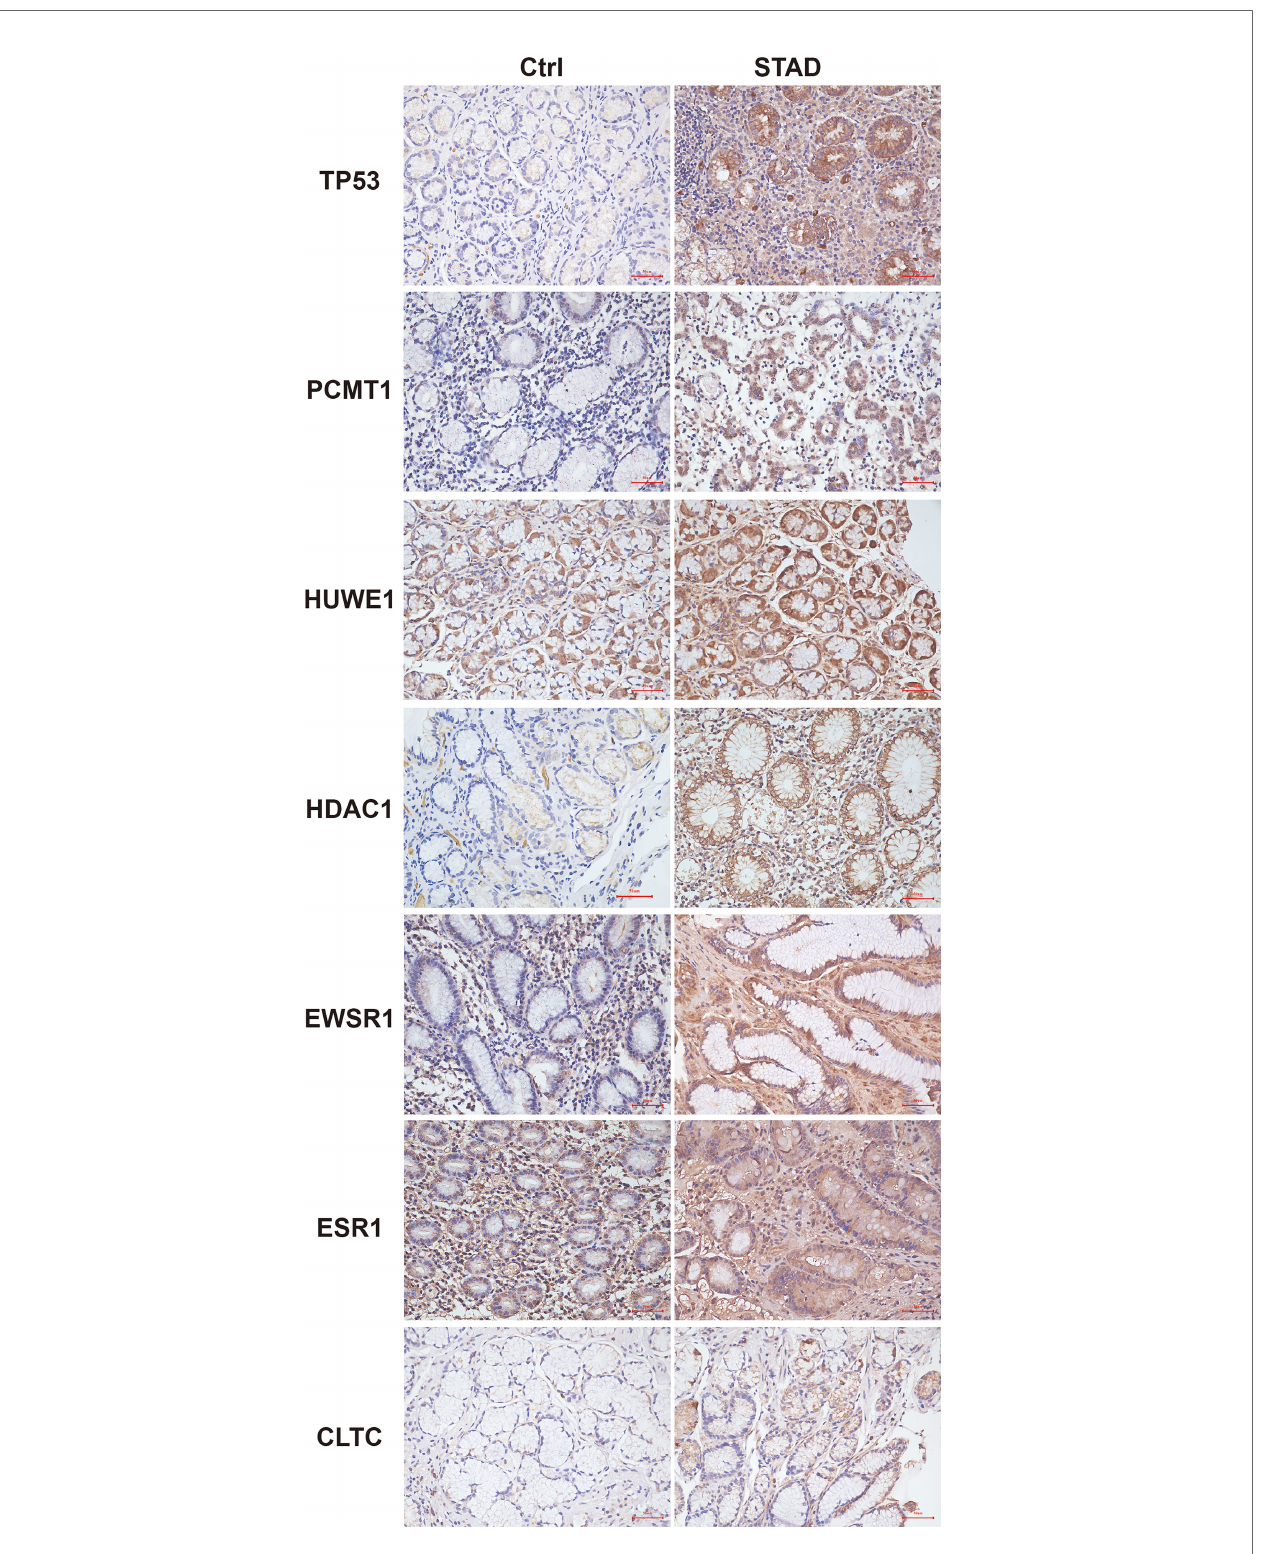
FIGURE 14 | Immunohistochemistry of the seven hub genes in STAD and normal tissues. Brown indicates the intensity of the expressed protein.